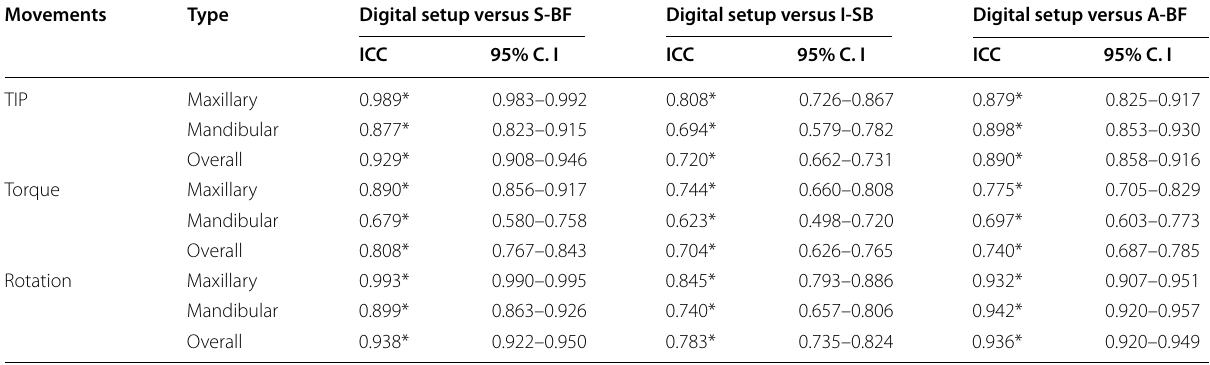
ICC, Intra Class Correlation Coefficient; CI, Confidence Interval; LL, Lower Limit; UL, Upper Limit *All values were significant at p ≤